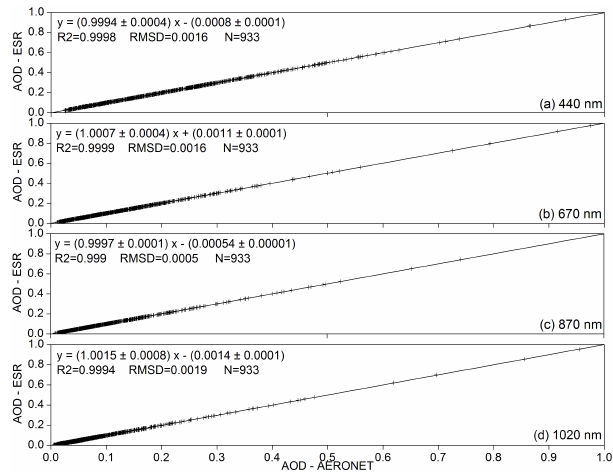
Fig. 5. Scatter plot and correspondent linear fitting for the AOD ob- tained by ESR and AERONET in mode 2 at (a) 440nm, (b) 675nm, (c) 870nm and (d) 1020nm